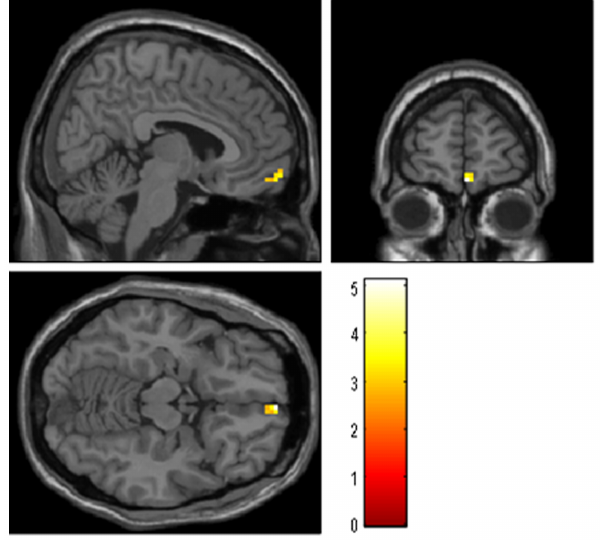
Figure 2. Brain regions showing decreased connectivity to left hippocampus in AD group comparing to control group. Left in picture is left in the brain. The color scale represents t values. Warm color represents decreased